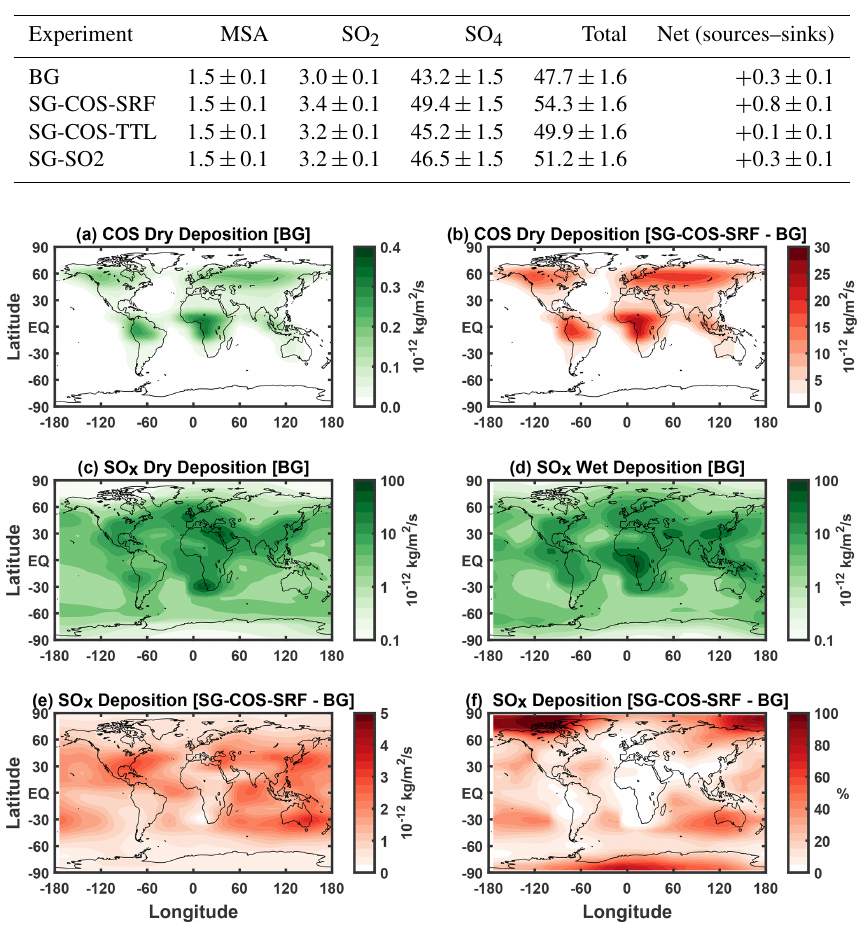
Table 3. Globally and annually averaged wet deposition rates of sulfur species (Tg − Syr − 1 ; years 2046–2055). The last column shows the net balance of total sulfur sources and sinks (Tg − Syr − 1